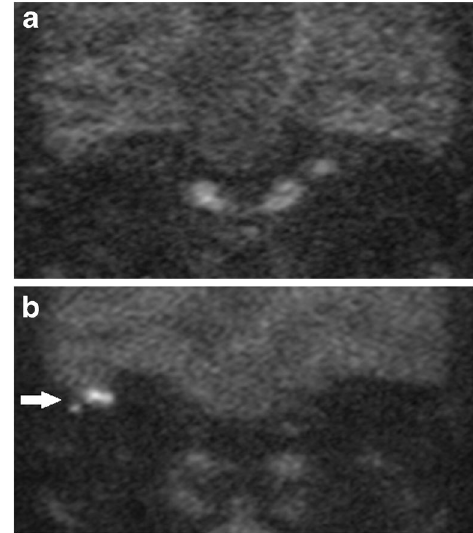
Fig. 6 Value of monitoring DWI scans which are negative for the presence of post-operative cholesteatoma. A year following right canal wall up surgery, the DWI scan was negative as shown by the a coronal b1000 image. The patient opted for monitoring with DWI instead of second-look surgery as his ear was dry. b A follow-up DWI scan a year later showed residual cholesteatoma ( white arrow ), which was confirmed on subsequent surgery